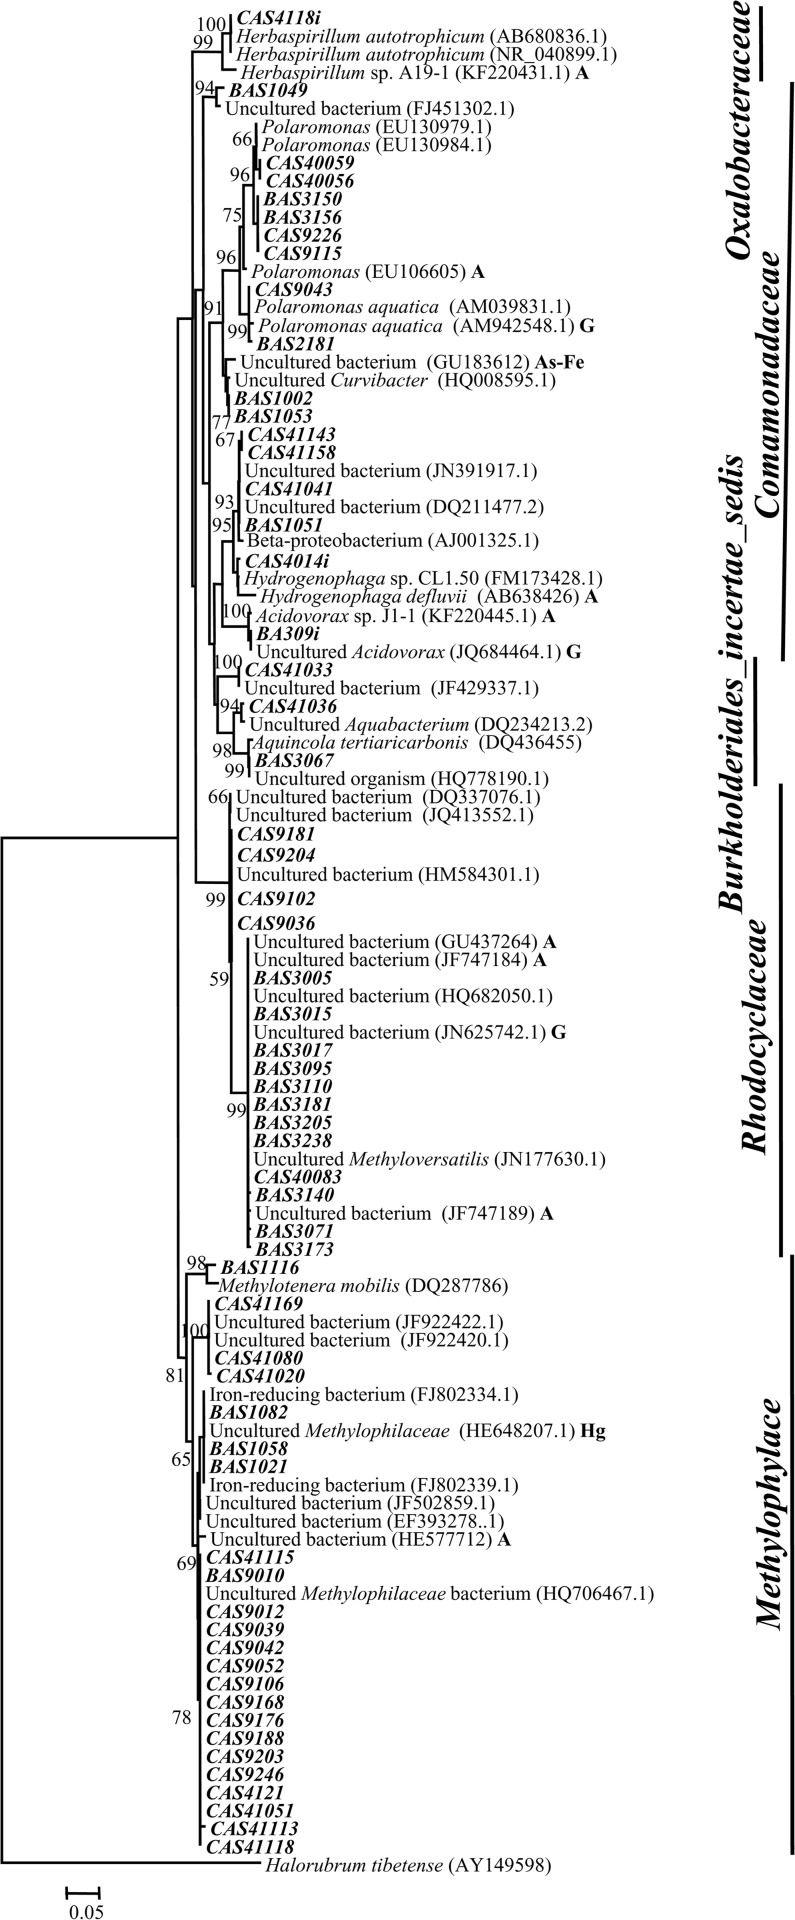
Neighbor-joining phylogenetic tree of β-Proteobacteria.The tree is constructed based on 16S rRNA gene sequences by using Jukes-Cantor distances. 1000 bootstraps analyses are conducted and more than 50% are denoted in nodes. Sequences retrieved from As contaminated environment, groundwater and mercury contaminated sites are suffixed here as ‘A’, ‘G’, and ‘Hg’, respectively. Sequences represented in bold italic font are derived from clone libraries and bold italic font with a suffix ‘i’ are derived from isolated strains.